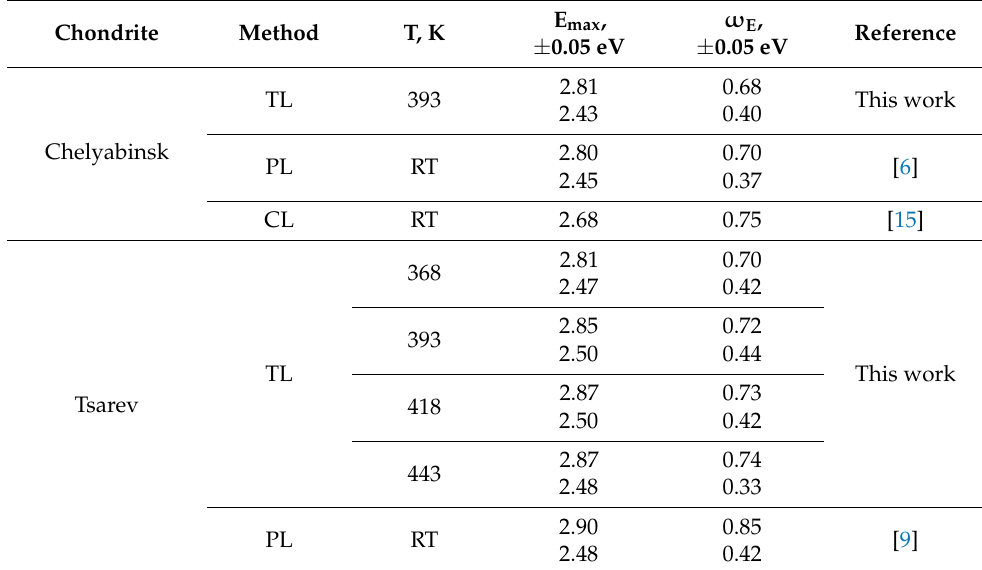
Table 1. Spectral parameters of luminescence for chondrites. Chondrite